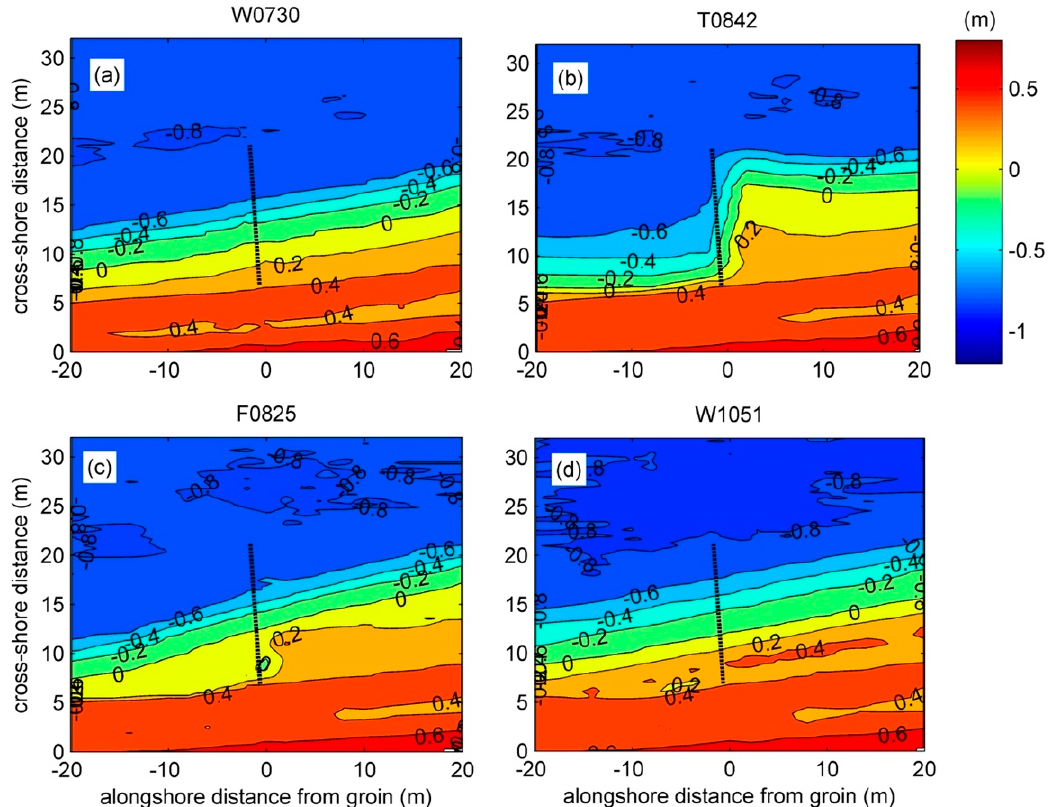
Figure 9. Beach survey ( a ) right before groin deployment, ( b ) right before groin removal (24 h later), ( c ) 24 h after groin removal, ( d ) 144 h after groin removal. The title of each subplot indicates the weekday and local time of each survey (W = Wednesday, T = Thursday, F = Friday).